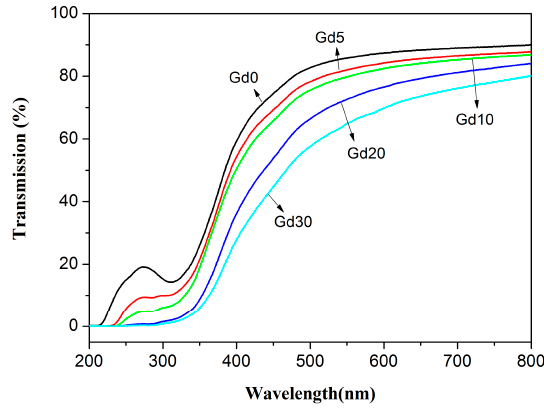
Figure 5. Optical properties of neat CS film and CS/GPs biocomposites.